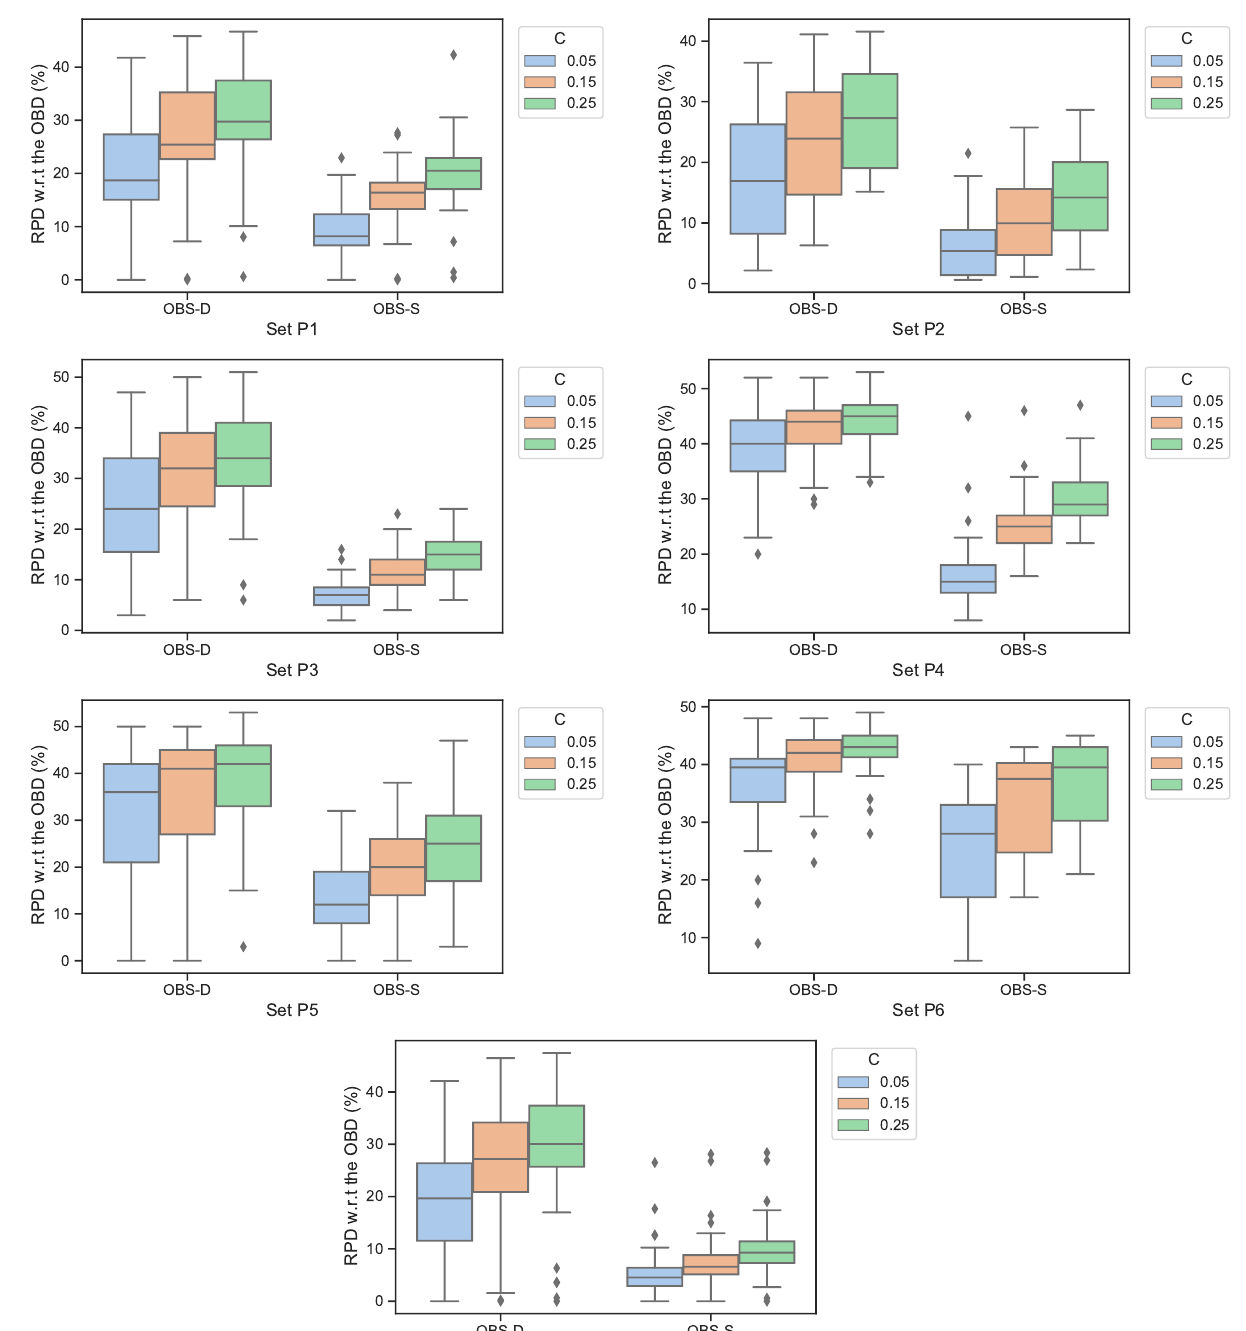
Figure 2. Comparison between OBD solutions with respect to stochastic